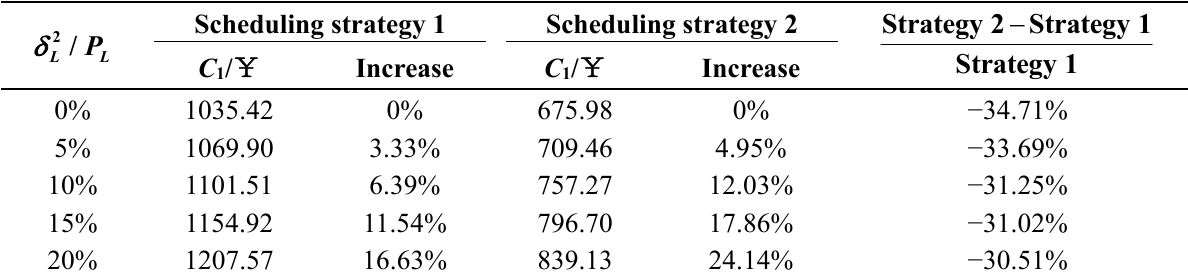
Table 8. Total cost of dispatch results under different load